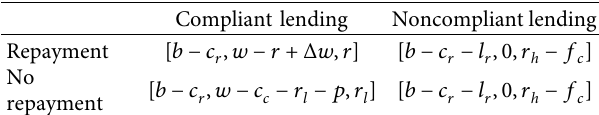
Table 2: Utility matrix if the society chooses to set up the ceiling.